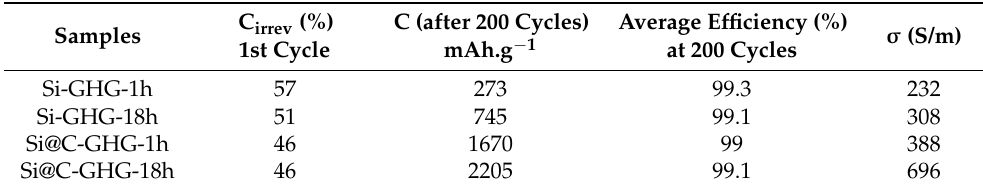
Figure 6. Battery performances of the samples in half-cells in 1 M LiPF6 in EC: DEC (1:1) with 10% FEC and 2% VC electrolyte. First cycles at C/20 with the corresponding irreversible capacities for Si-GHG samples ( a ) and Si@C-GHG samples ( b ). Cycling performances (discharge capacities) of the different samples at C/5 charging/discharging rate ( c ). Table 3. Summary of electrochemical characteristics of the tested samples: irreversible capacity after the 1st cycle, capacity after the 200th cycle, and the average of the coulombic efficiency recorded over 200 cycles, with a reminder of the bare sample conductivity.